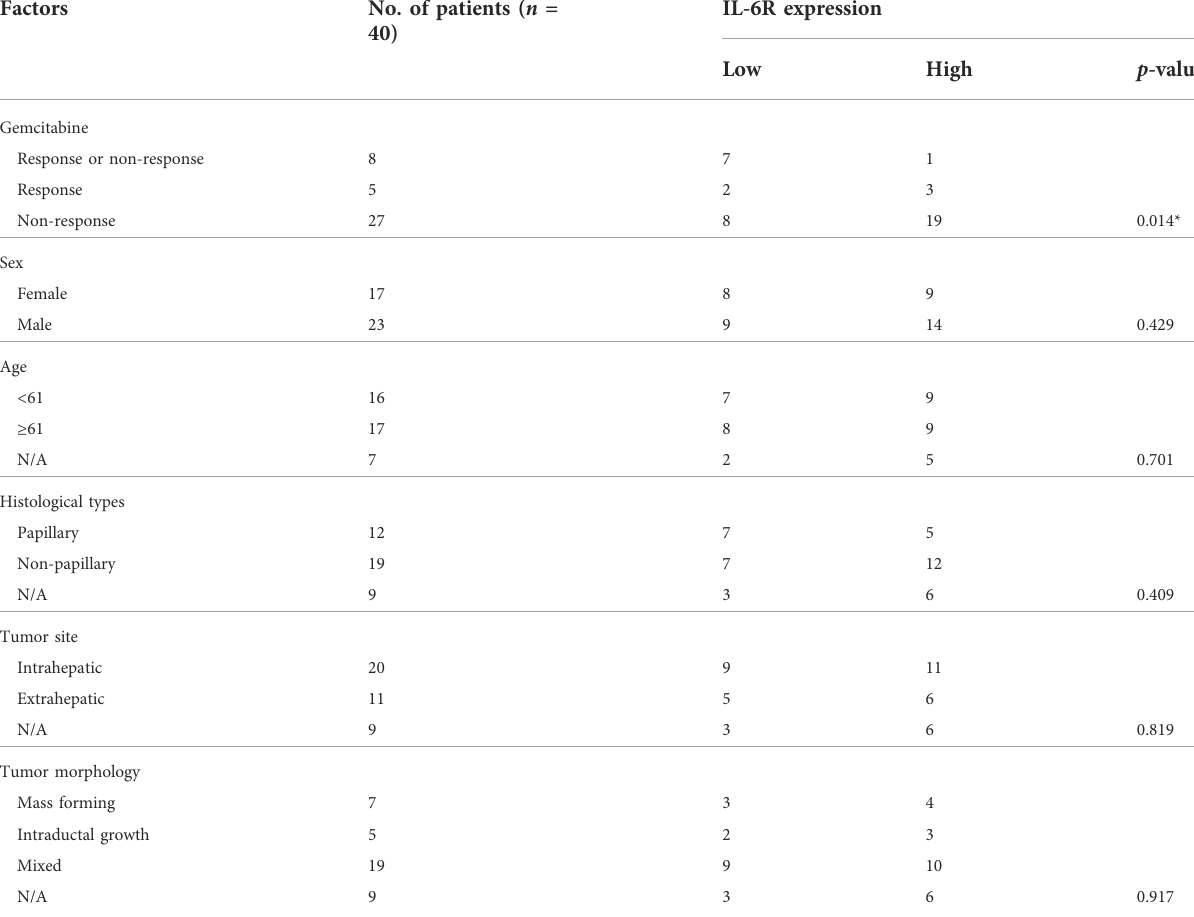
TABLE 3 Correlation of IL-6R expression with clinicopathological characteristics of CCA patients with gemcitabine response from HDRA results.